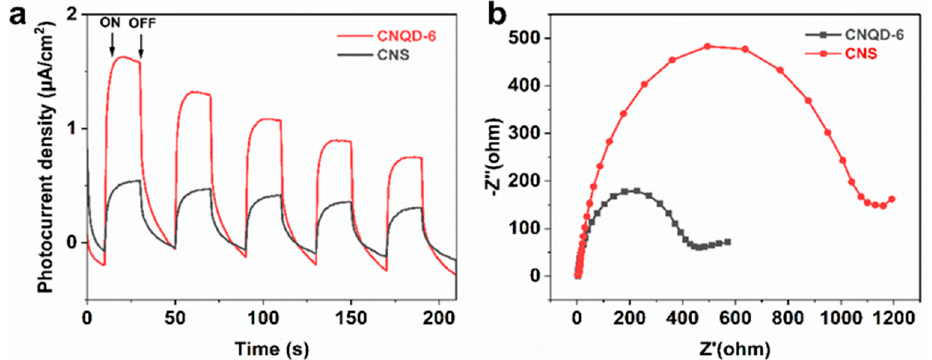
Figure 11. Transient photocurrent responses versus time ( a ) and EIS Nyquist plots ( b ) of CNS and CNQD-6 photocatalysts.